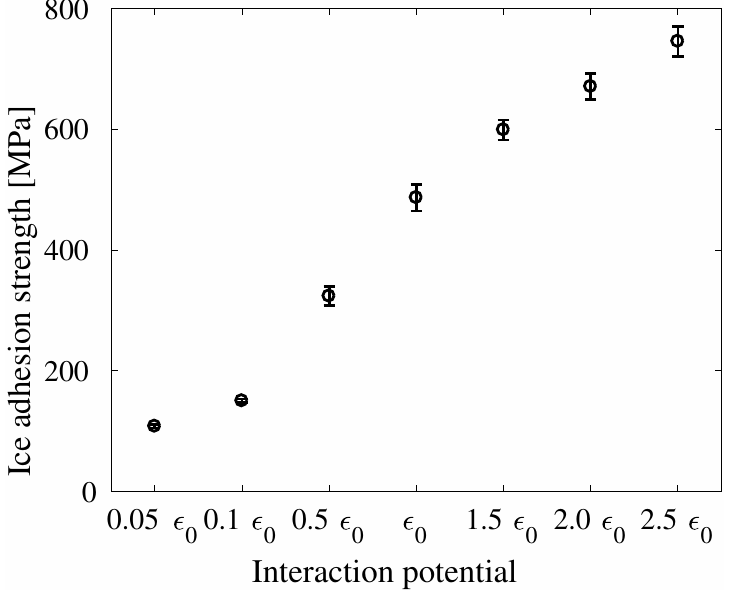
Figure 6. Ice adhesion strength τ as function of interaction potential ε for System A. The values of ε can be found in Table 1.